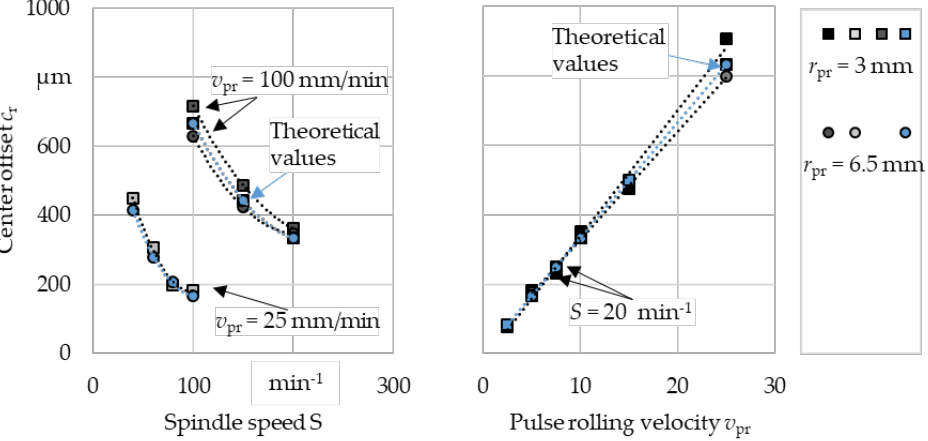
Figure 8. Influence of various spindle speeds S (left) and process velocity v pr (right) on the center offset c r .